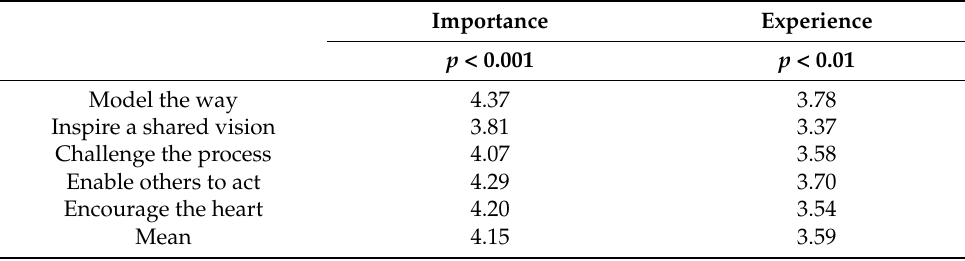
Table 4. Importance and experience for leadership